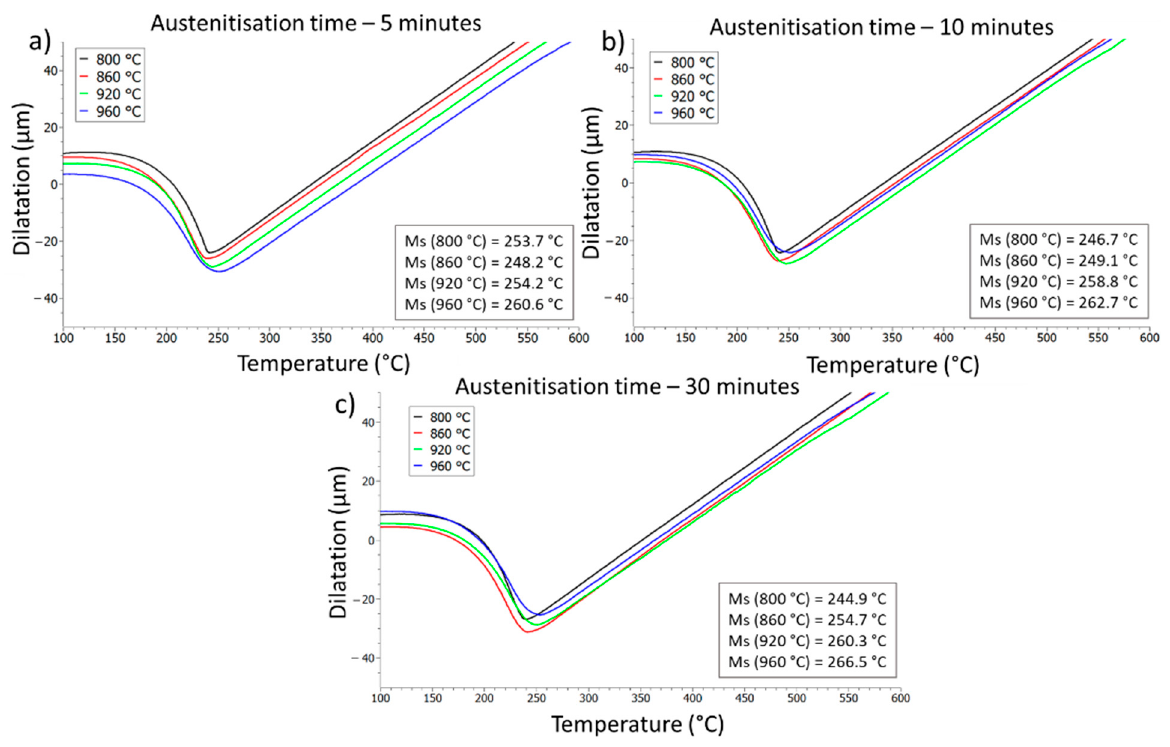
Figure 4. Dilatometric cooling curves of the samples heated at 800, 860, 920, 960 °C for ( a ) 5 min, ( b ) 10 min and ( c ) 30 min. Table 2. M S , hardness and austenite grain size of quenched samples.